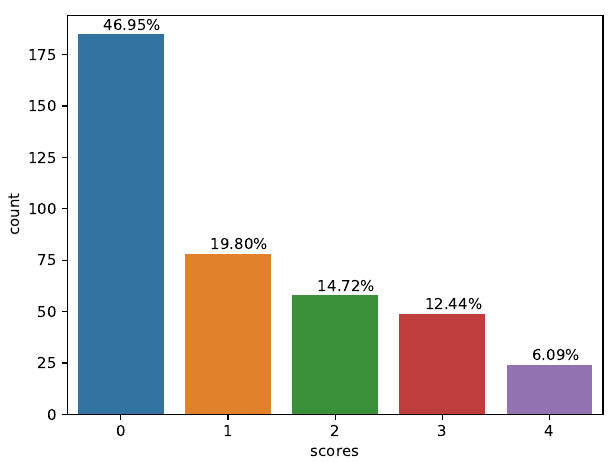
Figure 5. Student performance analysis on the student performance dataset.